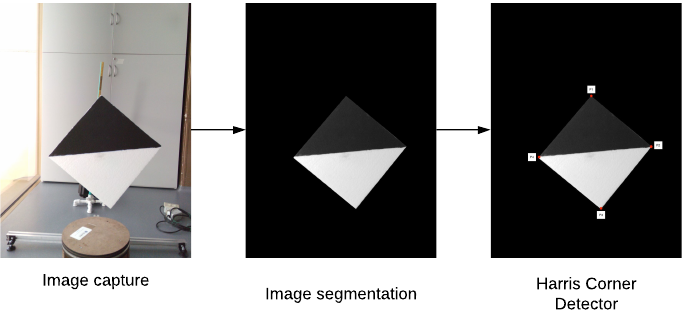
Figure 14. Oversampling and outlier removal on the the point clouds. (a) Raw point cloud of the Limonaria plant. (b) Regions of the point cloud where unwanted points are found (in red). (c) Point cloud after oversampling, averaging and filtering.